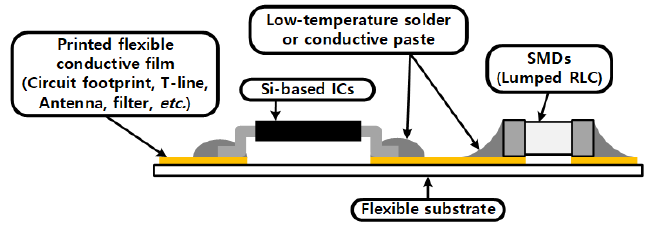
Figure 2. A typical topology of flexible hybrid printed electronics.